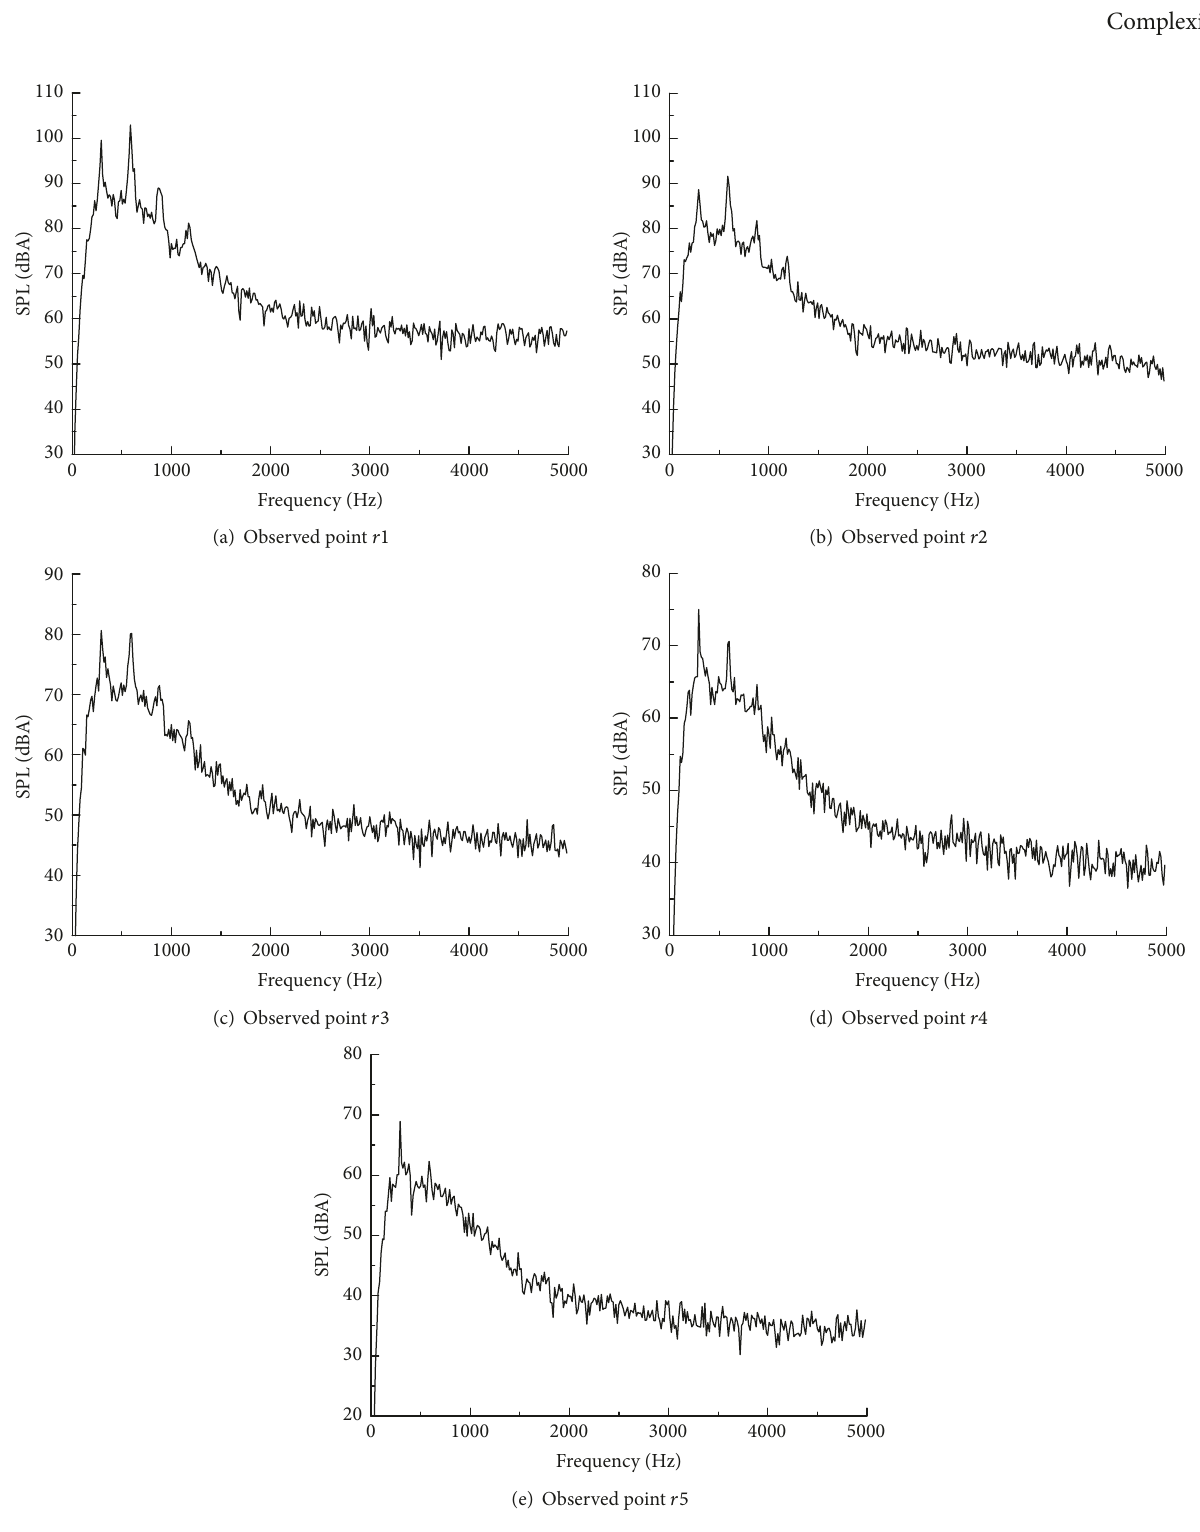
Figure 13: Comparisons of frequency spectrums at observed